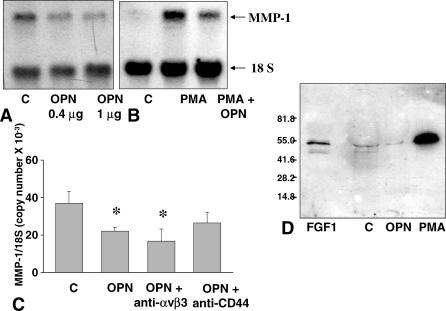
Effects of Osteopontin on MMP-1 Gene and Protein Expression in Two Human Lung Fibroblast Cell Lines(A) Representative Northern blot of 20 μg total cellular RNA per lane extracted from control cells and fibroblasts stimulated with 0.4 μg/ml and 1 μg/ml osteopontin. Both concentrations of osteopontin induced a down-regulation in the expression of MMP-1.(B) Osteopontin also reduced overexpression of MMP-1 in APMA-stimulated cells.(C) The expression level of MMP-1 by real-time PCR was determined as described in Materials and Methods and normalized to the level of 18S ribosomal RNA. In parallel experiments, osteopontin-stimulated cells were treated with anti-αvβ3 and anti-CD44. Bars represent mean ± SD (*p < 0.05).(D) Representative Western blot demonstrating a decrease of immunoreactive MMP-1 in conditioned media from fibroblasts stimulated with osteopontin. Fibroblasts treated with APMA and FGF-1 plus heparin used as positive controls strongly induced MMP-1 expression.C, control; FGF1, FGF-1 plus heparin; OPN, osteopontin; PMA, APMA-stimulated.